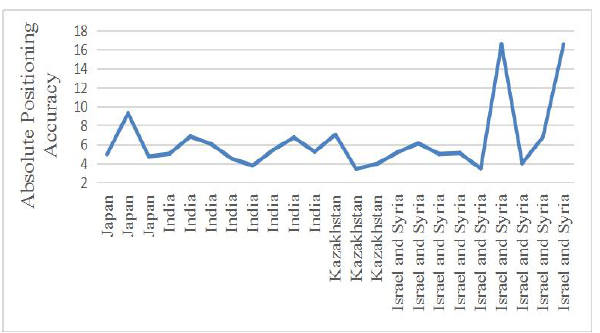
Figure 2. Absolute accuracy variation of GE’s data over